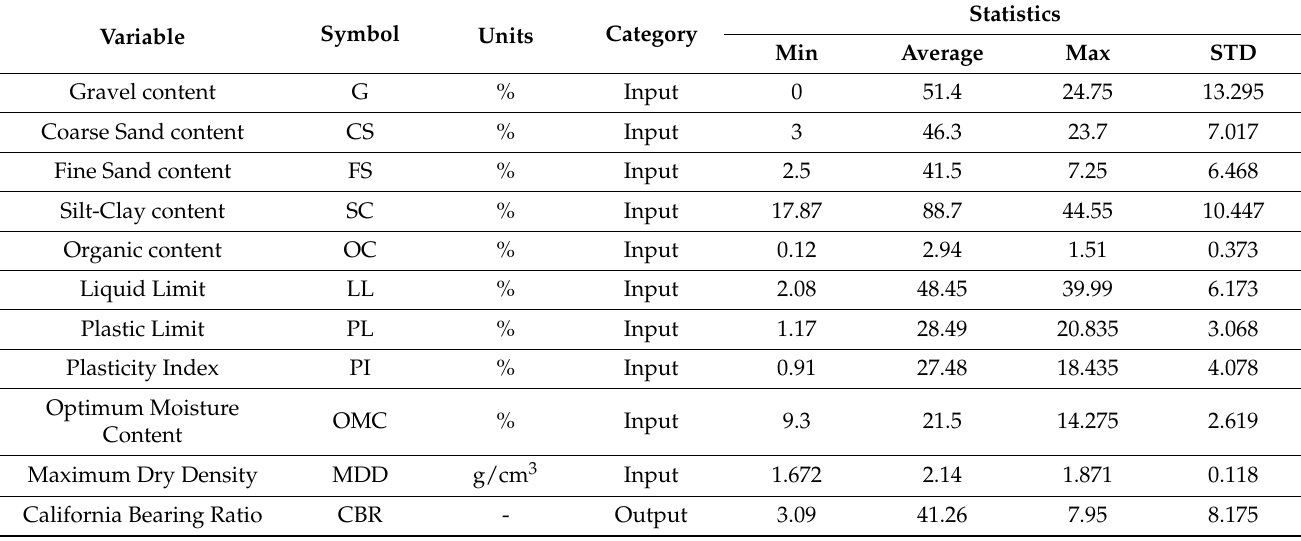
Table 2. Statistical analysis of the input and output